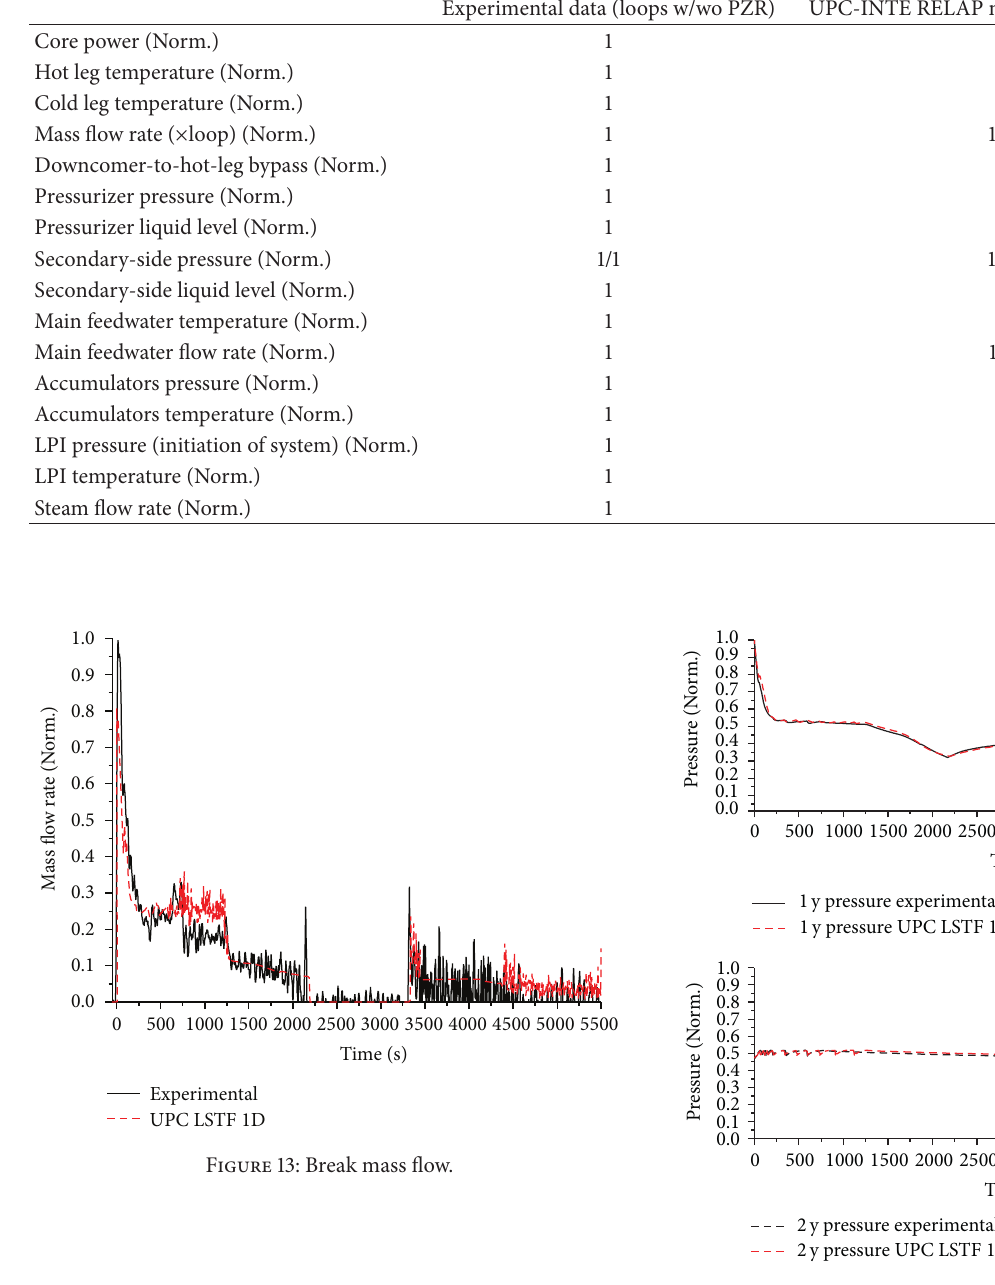
Figure 14: System